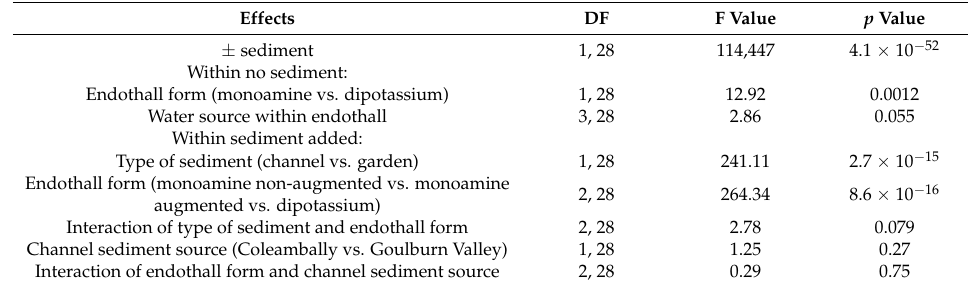
Table 5. Analysis of variance for treatment effects on endothall isomer-1 as % decline between day-0 and day-21. The data is analyzed after a log10(1.1-(%decline/100)) transformation. Treatment 14 is excluded from analysis (see methods). DF = Degrees of freedom.